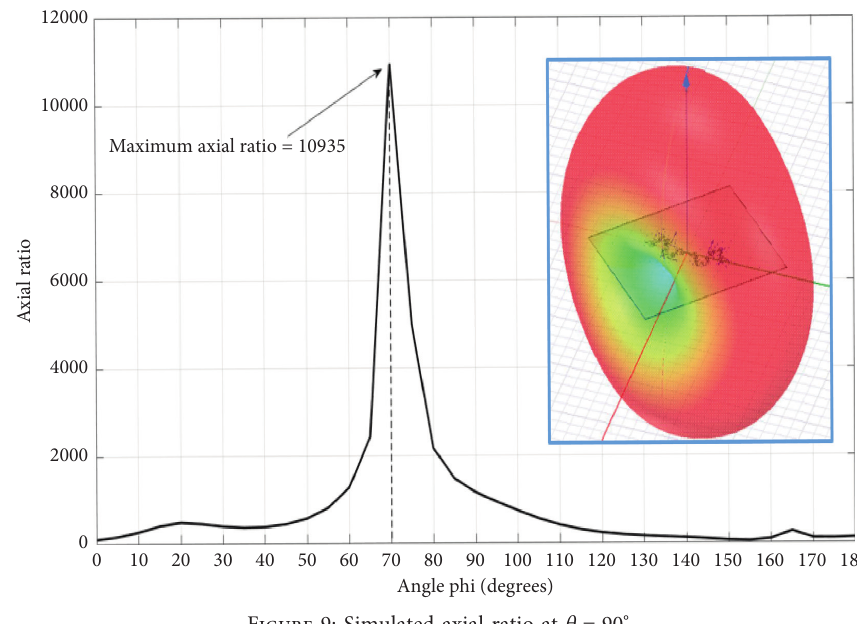
Figure 9: Simulated axial ratio at θ � 90 ° . Table 2: Comparison of parameters obtained by simulations and measurements for the proposed antenna on FR4-G10. Type of